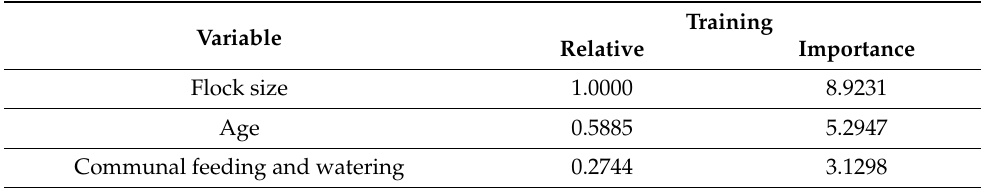
Table 3. Important scores of the Classification and Regression Tree for selecting the risk factors of